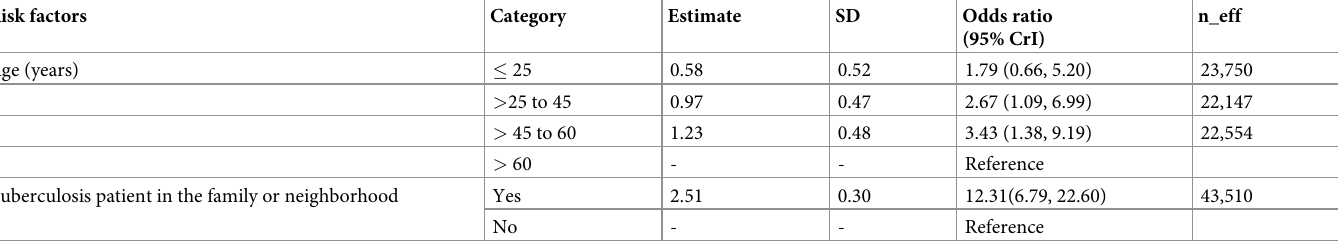
Table 2. Risk factors retained in the final Bayesian mixed-effects multivariable logistic regression model for tuberculosis (TB) among TB suspects in Mymensingh, Sirajganj and Dhaka, Bangladesh.